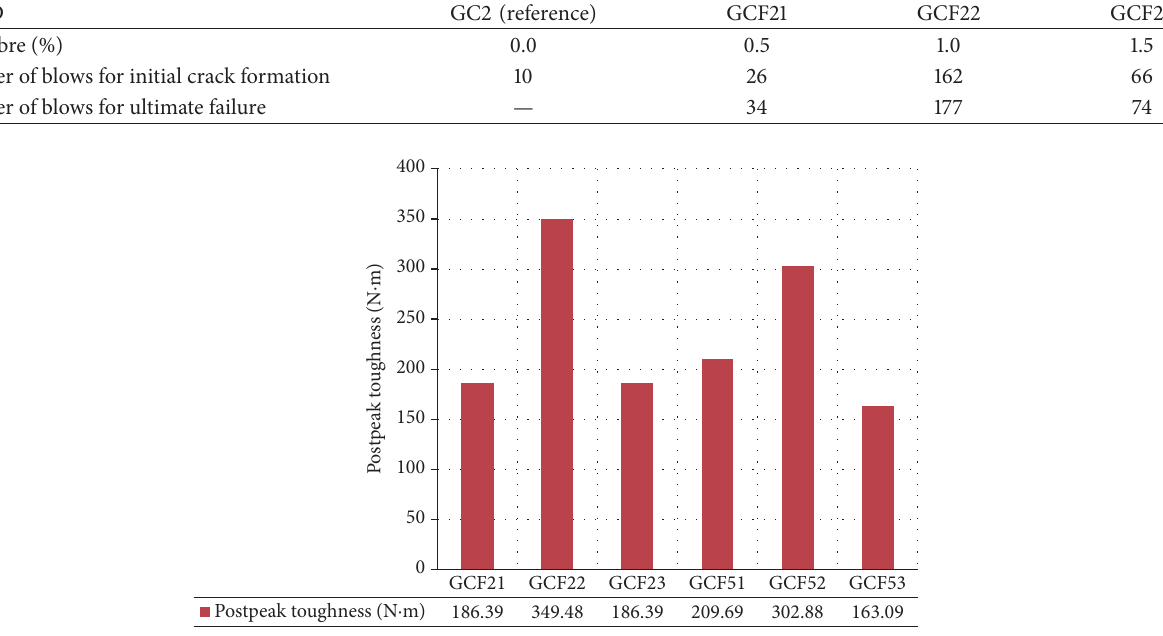
impact test. From the observations the concrete mix ratio of GCF22 (binder to total aggregate ratio of 0.22 and fine to coarse aggregate ratio of 0.6 with 1.0% of steel fibre) was showing the better performance; in punching shear the stress was 11.9 N/mm 2 and in impact test the energy absorption of mixture GCF22 shows 3541.41 N ⋅ m in increase in toughness of first crack and 349.48 N ⋅ m in postpeak toughness. So it is observed that 1.0% of steel fibre is optimised and mixture GCF22 is suggested to be better in shear and energy